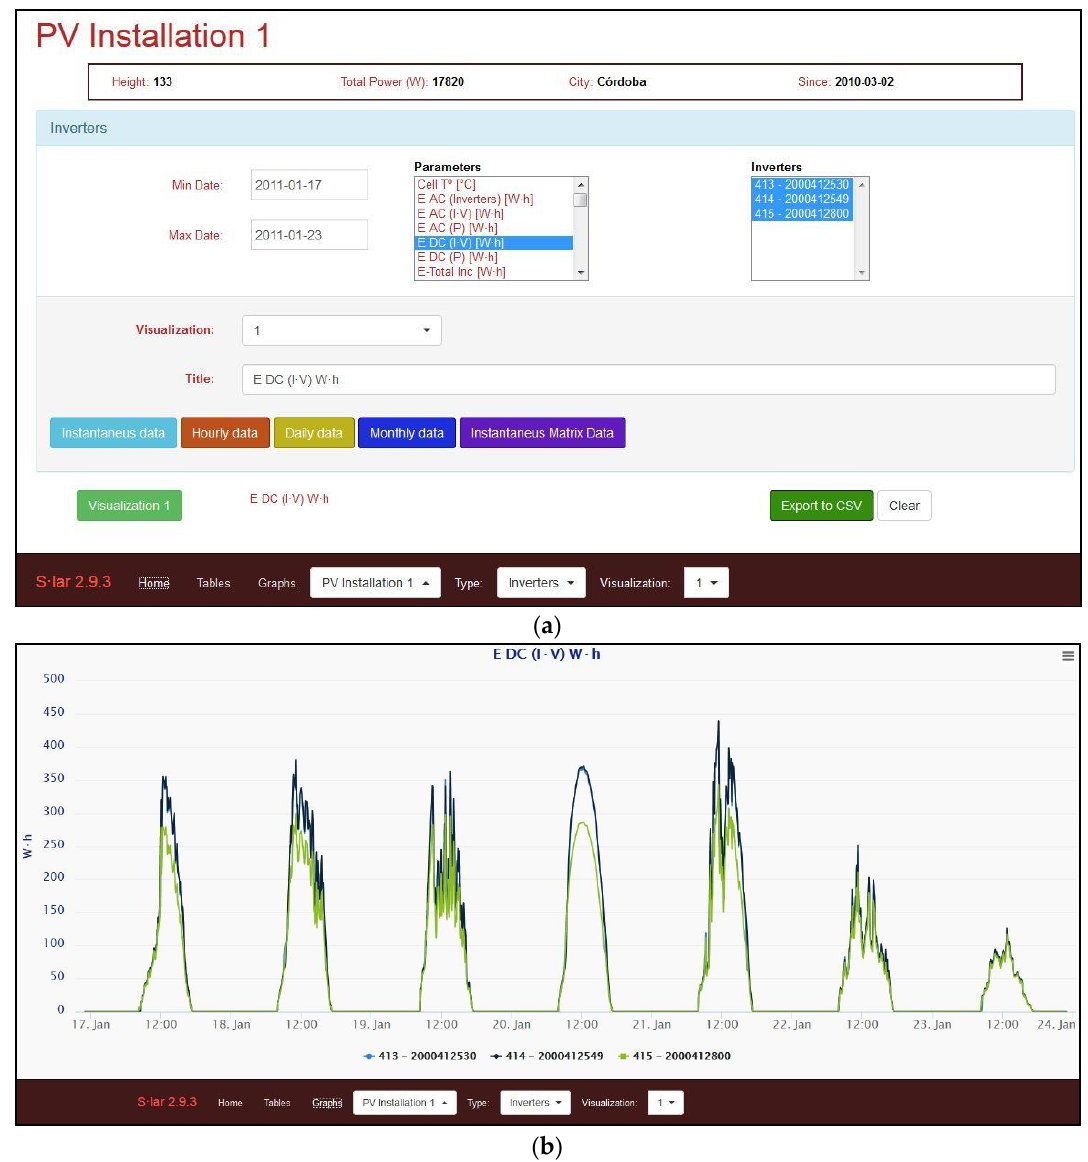
Figure 2. S·lar 2’s graphical user interface (GUI): ( a ) selection of data; and ( b ) graphical visualization of selected parameter ( E DC ) for the three inverters.